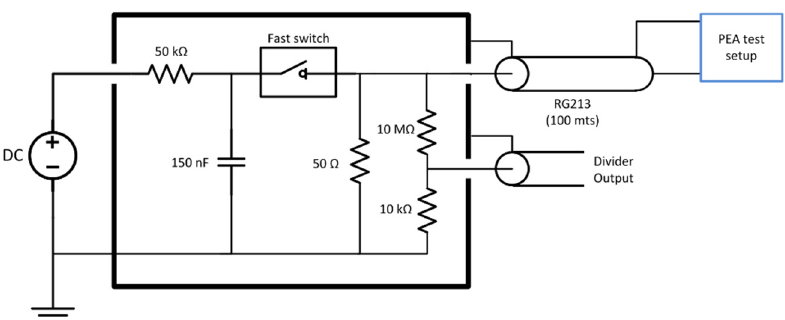
Figure 2. Voltage pulse generator equivalent circuit.